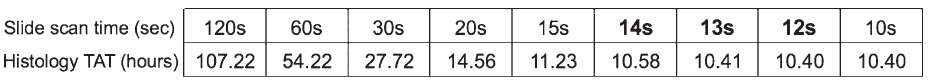
Fig. 7. Average WSI robot scan times needed for a single robot to maintain the current workflow in a high-volume (2400 slides/day) clinical histology laboratory. Bolded numbers above denote the point at which further decreases in the slide scan time have little to no effect on histology lab turn-around-time